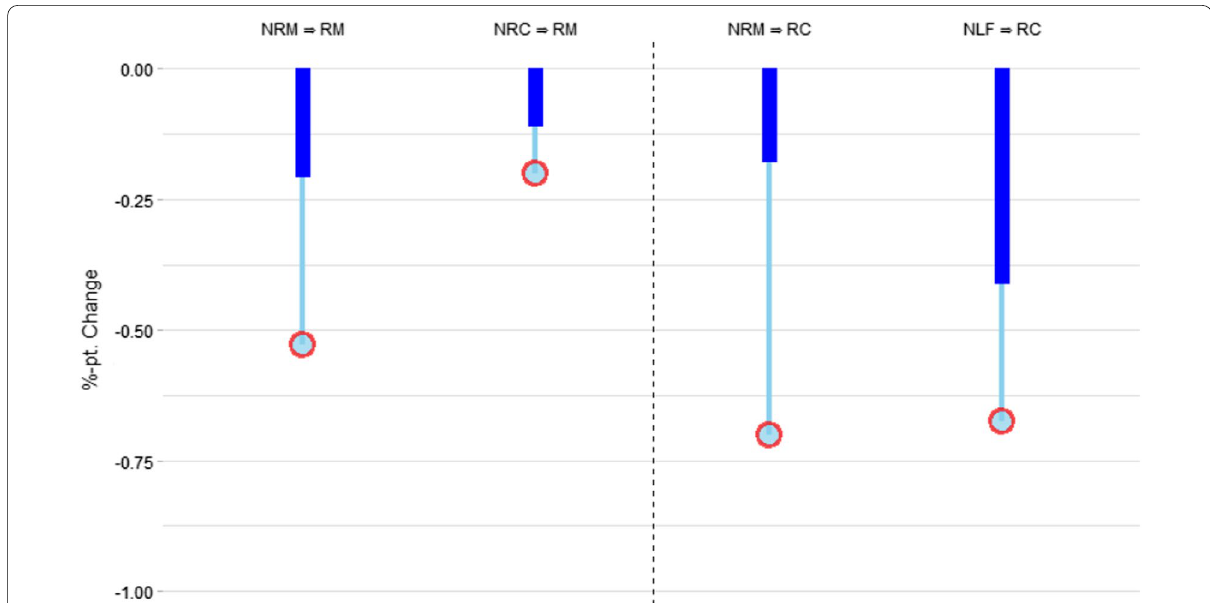
Fig. 3 Changes in Key Inflow Rates into RM and RC employment. Notes: Dark blue bars show percentage point changes in transition rates between phase I and phase II, and light blue bars show percentage point changes in transition rates between phase II and phase III. Red circles mark overall percentage point changes in transition rates between phase I and phase